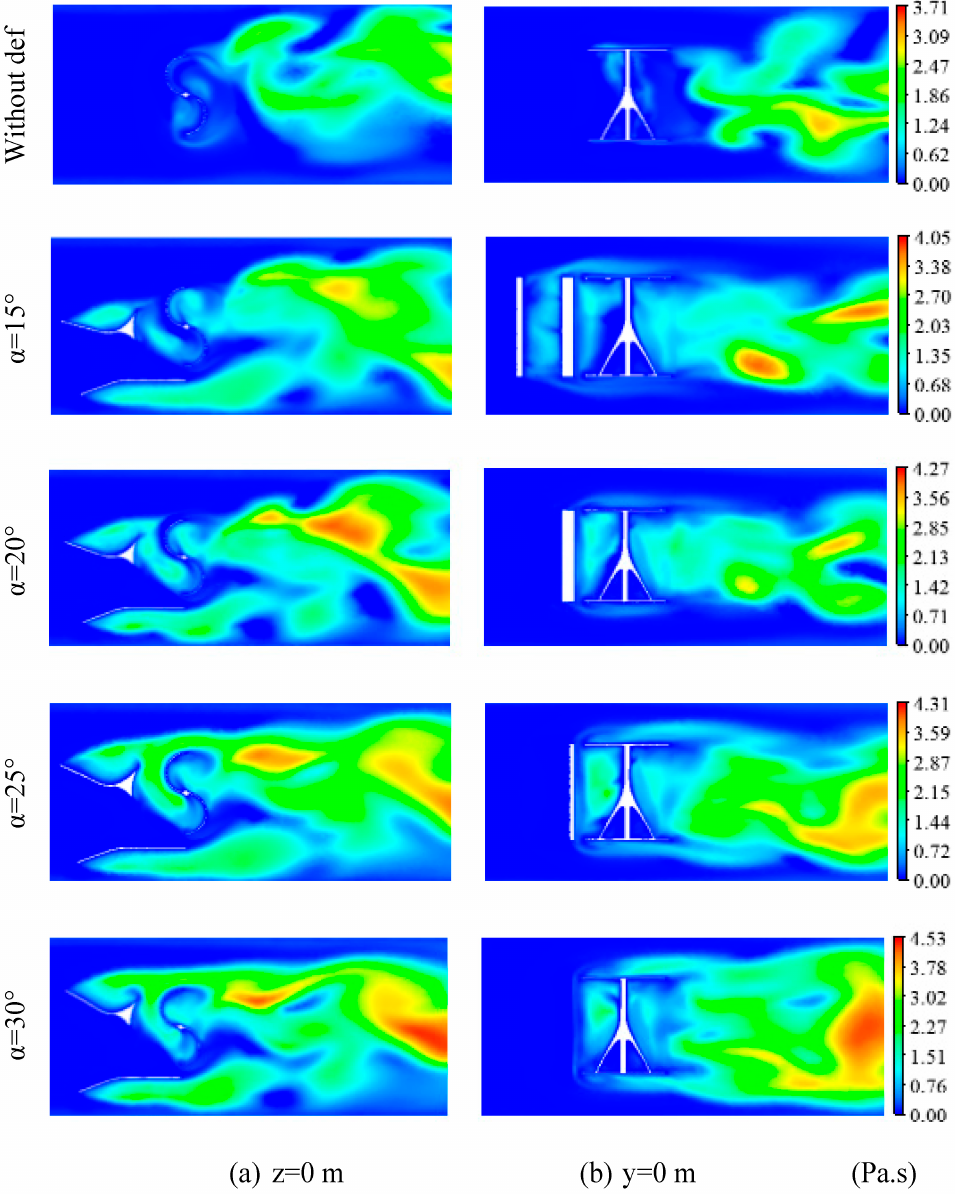
Figure 17. Turbulent viscosity distribution for different deflection angles.